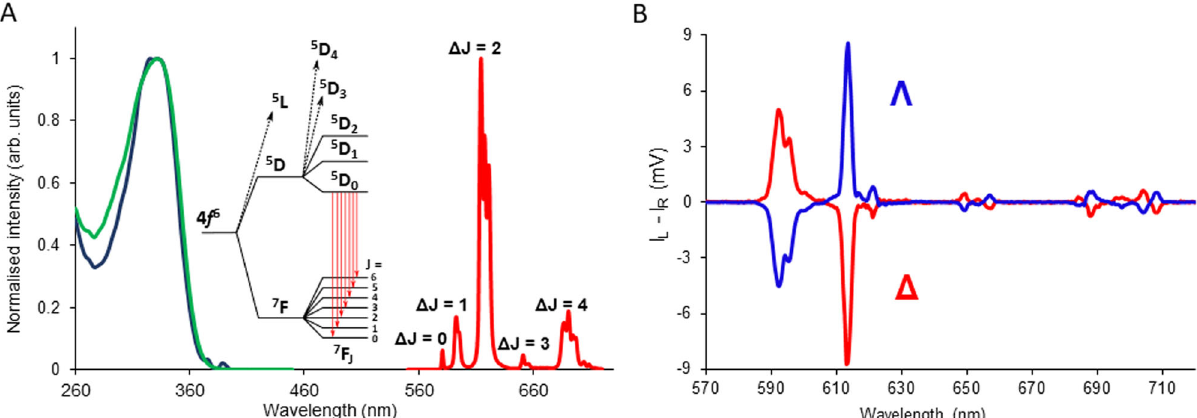
Δ - (red) and Λ - (blue) enantiomers of Eu:L1. Both spectra were recorded in EtOAc, 295K, 5 μ M complex, λ exc =355nm, 5 scans averaged with 0.5nm resolution and 1ms integration